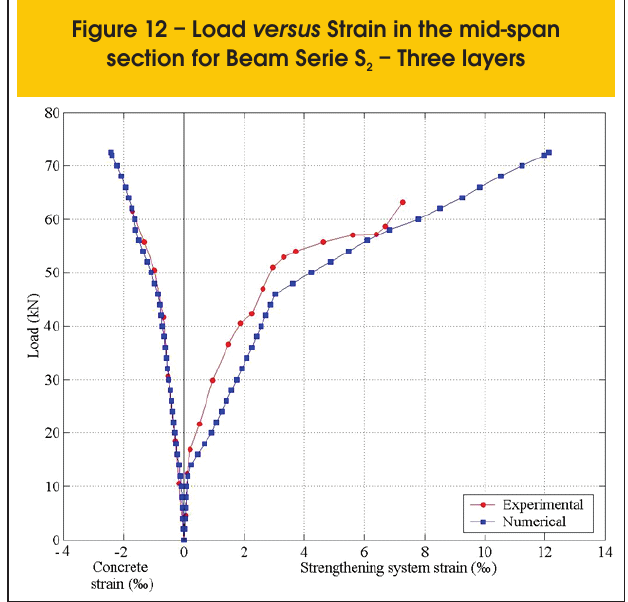
Figure 12 – Load versus Strain in the mid-span section for Beam Serie S – Three layers 2